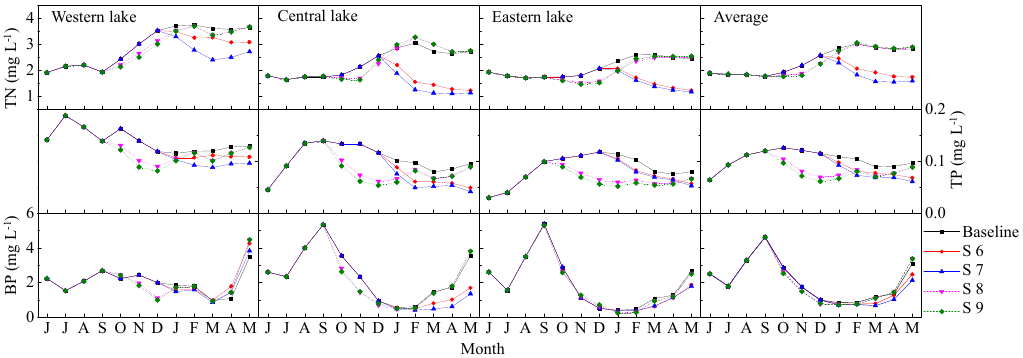
Figure 9. The concentration of TN, TP, and BP in Lake Yangchenghu during water transfer.